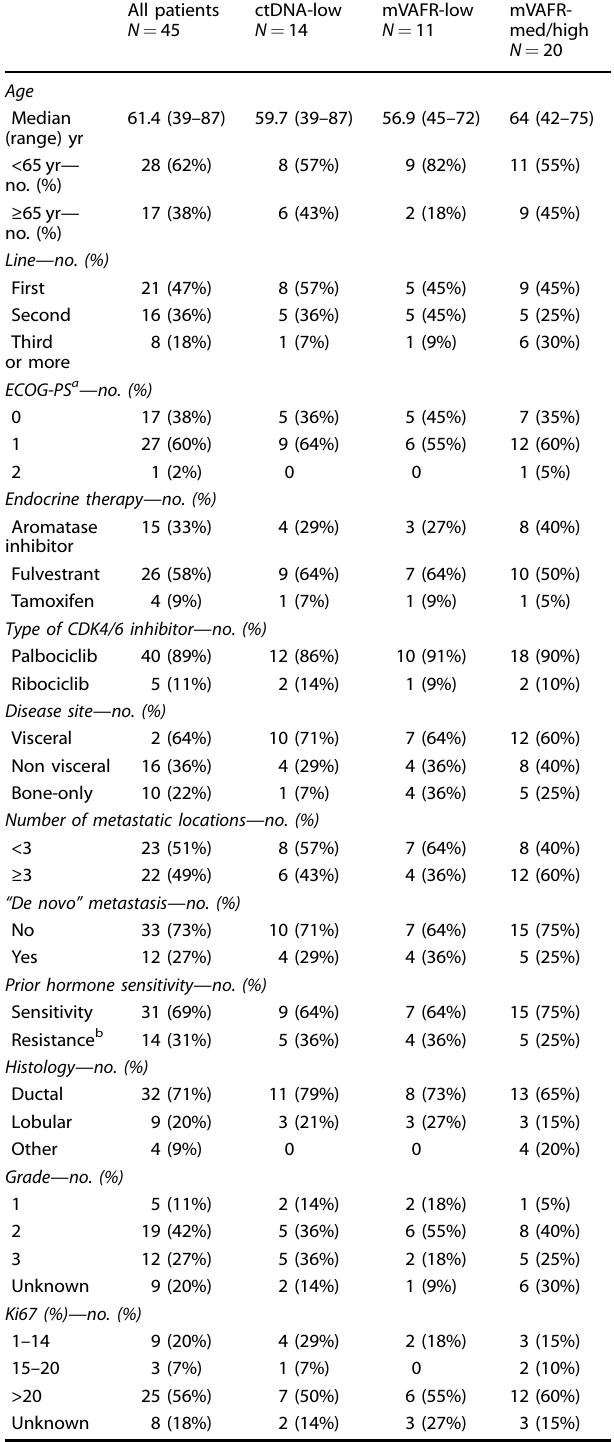
Table 1. Clinical features of the patient dataset according to ctDNA levels and dynamics. All patients N =